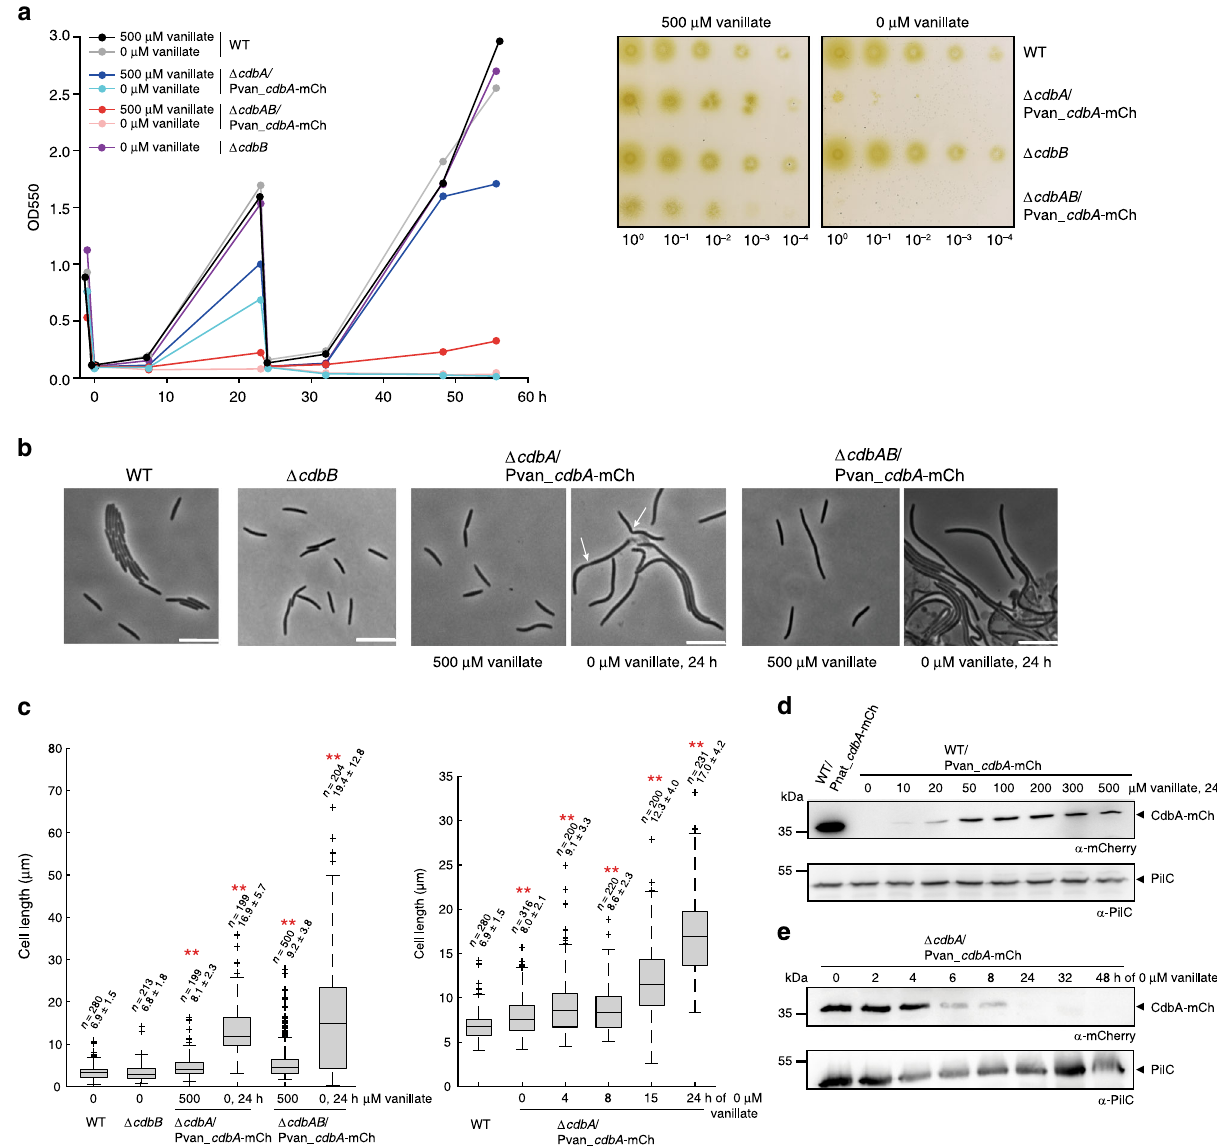
Fig. 4 CdbA is essential for growth and CdbB is dispensable. a Growth of indicated strains in suspension (left) and on solid surface (right) in the presence and absence of vanillate driving synthesis of CdbA-mCh. In the plating assay, plates were incubated for 4 days. Similar results were obtained in two independent experiments. Source data are provided as a Source Data fi le. b Phase contrast microscopy of representative cells of indicated genotypes grown in the presence or absence of vanillate. Cell were grown ±vanillate for 24 h. Arrows indicate constrictions. Scale bars, 10 μ m. Similar results were obtained in two independent experiments. c Cell length distribution of cells of indicated genotypes grown in the presence or absence of vanillate. Left panel, cell length distribution of cells grown ±vanillate for 24 h; right panel, cell length distribution at different timepoints during vanillate depletion. In the boxplots, boxes enclose the 25th and 75th percentile with the black line representing the mean, whiskers indicate the 10th and 90th percentile, and “ + ” indicates outliers. Numbers above each box indicate number of cells used for quanti fi cation (n) and mean ± standard deviation (SD). Cells were treated as in b . ** p < 0.001 in two-sided Student ’ s t -test, in comparison to WT. Exact p -values and source data are provided in the Source data fi le. d Immunoblot analysis of CdbA-mCh accumulation. CdbA-mCh expression was induced with the indicated concentrations of vanillate for 24 h before cells were harvested. The WT/ Pnat_ cdbA -mCh strain was used as a control for the native CdbA level. PilC was used as a loading control. Protein from the same number of cells was loaded per lane. Molecular mass marker is indicated on the left. Similar results were obtained in two independent experiments. Source data are provided as a Source Data fi le. e Immunoblot analysis of CdbA-mCh accumulation in the Δ cdbA /Pvan_ cbdA- mCh strain during time course of vanillate depletion. PilC was used as loading control. Protein from the same number of cells was loaded per lane. Molecular mass marker is indicated on the left. Similar results were obtained in two independent experiments. Source data are provided as a Source Data fi